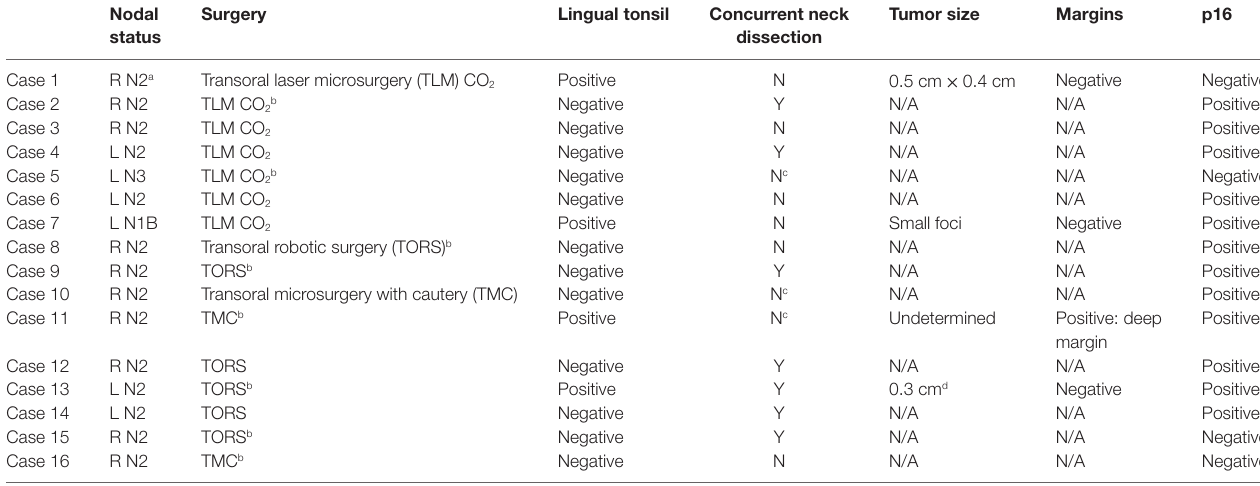
Table 2 | Patient nodal status, surgery, and